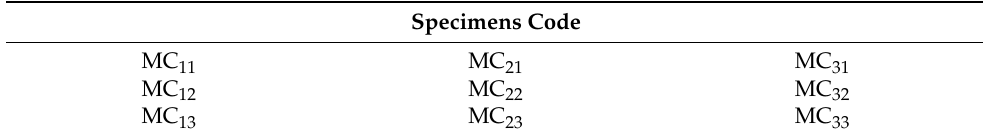
Table 2. Specimens for rheological and mechanical characterization.